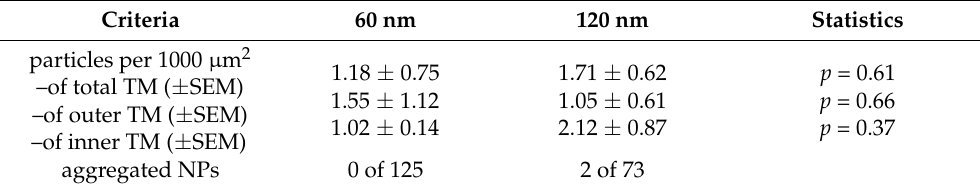
Table 1. Quantitative evaluation of distribution of 60 or 120 nm HA-AuNPs in TEM images. Three independent experiments were conducted. TM = trabecular meshwork.